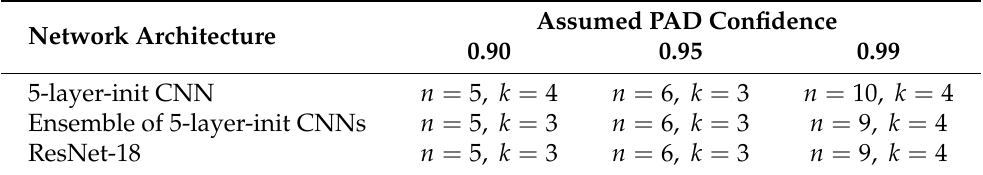
Table 6. Required challenge length ( n —in phonemes) and the minimum number of correct matches ( k ) for different assumed presentation-attack detection confidence levels and selected